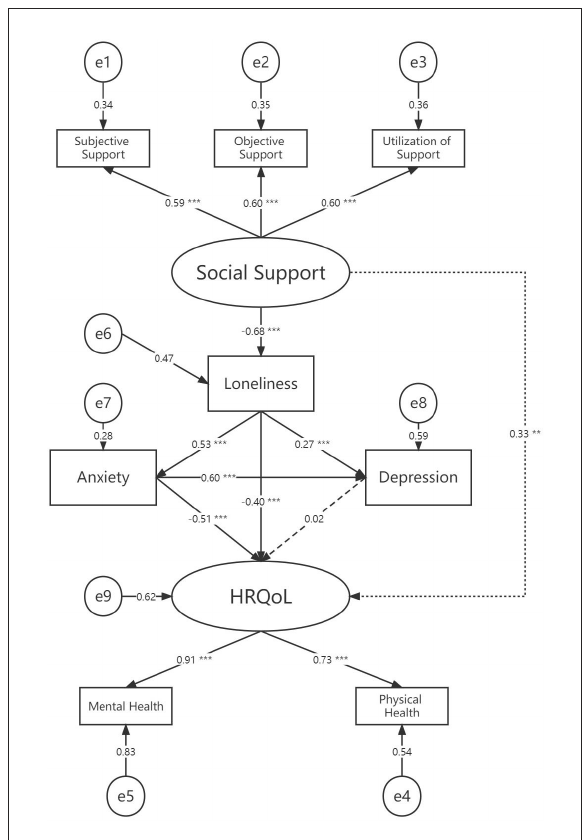
FIGURE4 Structural equation model for the mediation mechanism of loneliness with standardized beta weights and significant